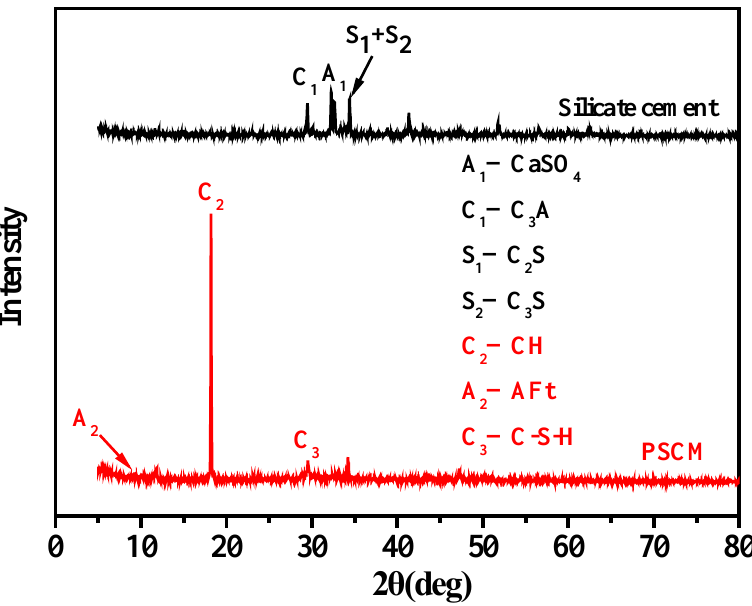
Figure 3. XRD of the silicate cement and PSCM based on the hot–dry casting technique.